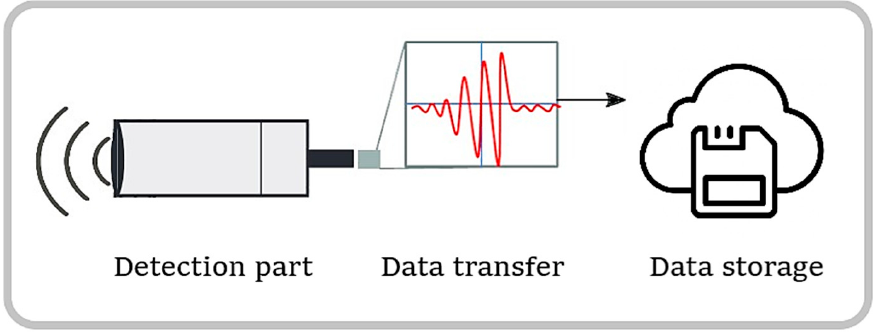
Figure 1. Schematic of a data acquisition system.